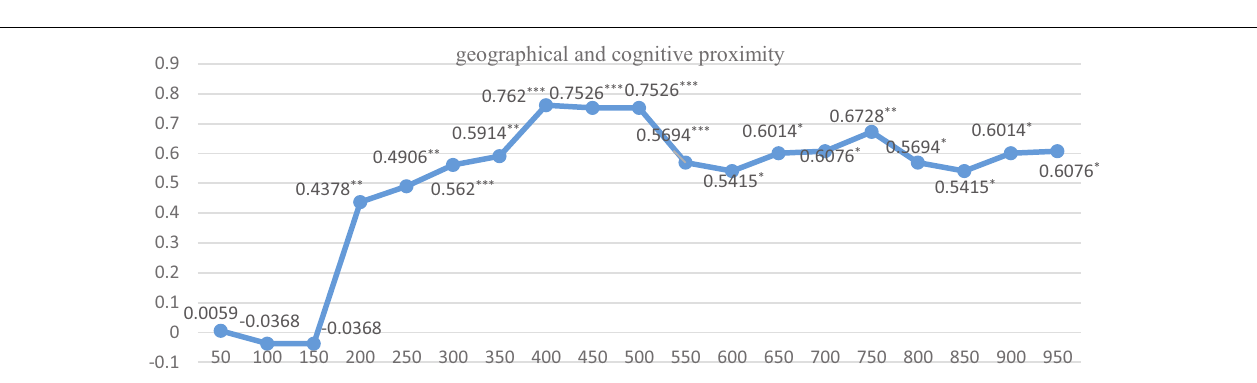
FIGURE 5 | The regression results under geographic and social weight matrix with different kilometers. *** and ** indicate that the significance level is at the 1% and 5%, respectively.